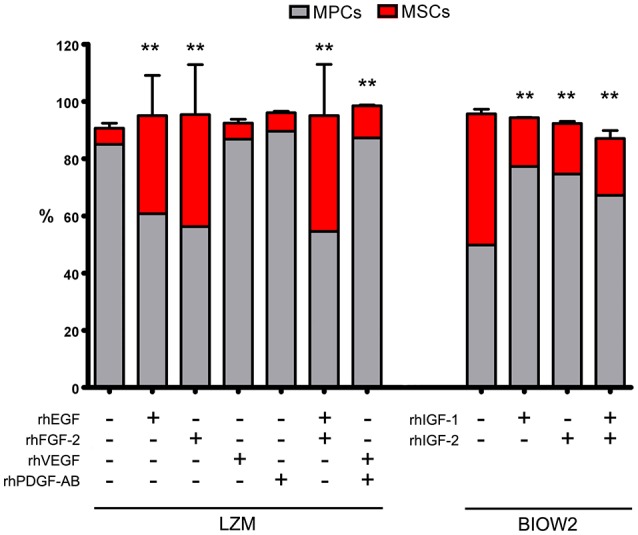
Managing hGF medium contents, by adding recombinant factors, affected the sera performance during MPC isolation. Adding rhEGF or rhFGF-2, alone or in combination, to the cultures supplemented with good performance serum (LZM), resulted in significantly increased MSC-like population (red bars). Under these conditions, MPC/MSC ratio was comparable to those reported applying MSC-inducing PhABS. Treating with rhVEGF or rhPDGF-AB had no effects on MPC isolation, but a combination of those two hGFs produced mild but significant increase in MSC-like counterpart. BIOW2 batch was selected as PhABS with poor performance, evaluating the effects of rhIGF-1 and rhIGF-2 during MPC isolation. The treatment with rhIGFs, either alone or in combination, produced a 50% reduction of the MSC-like population (**p < 0.01, respect to control).